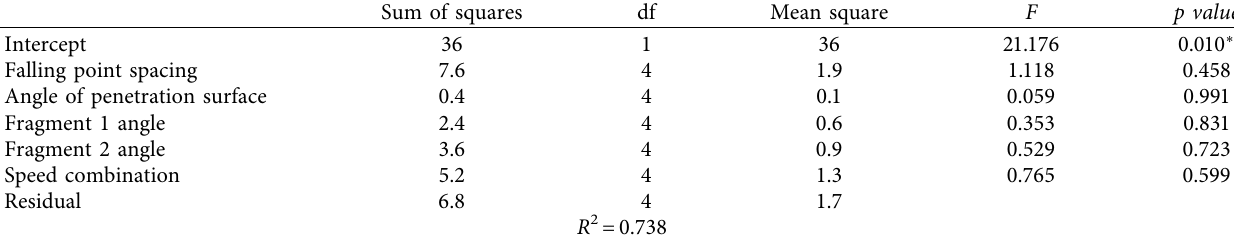
Table 11: Results of multifactor ANOVA of overall combined damage.